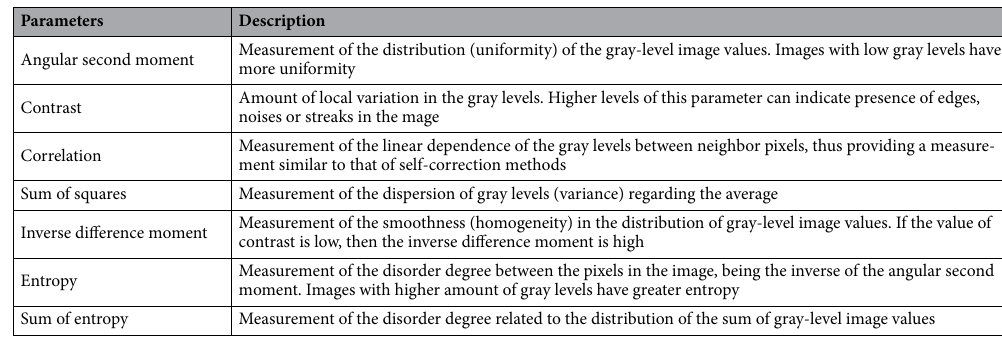
Table 1. Texture parameters used in the